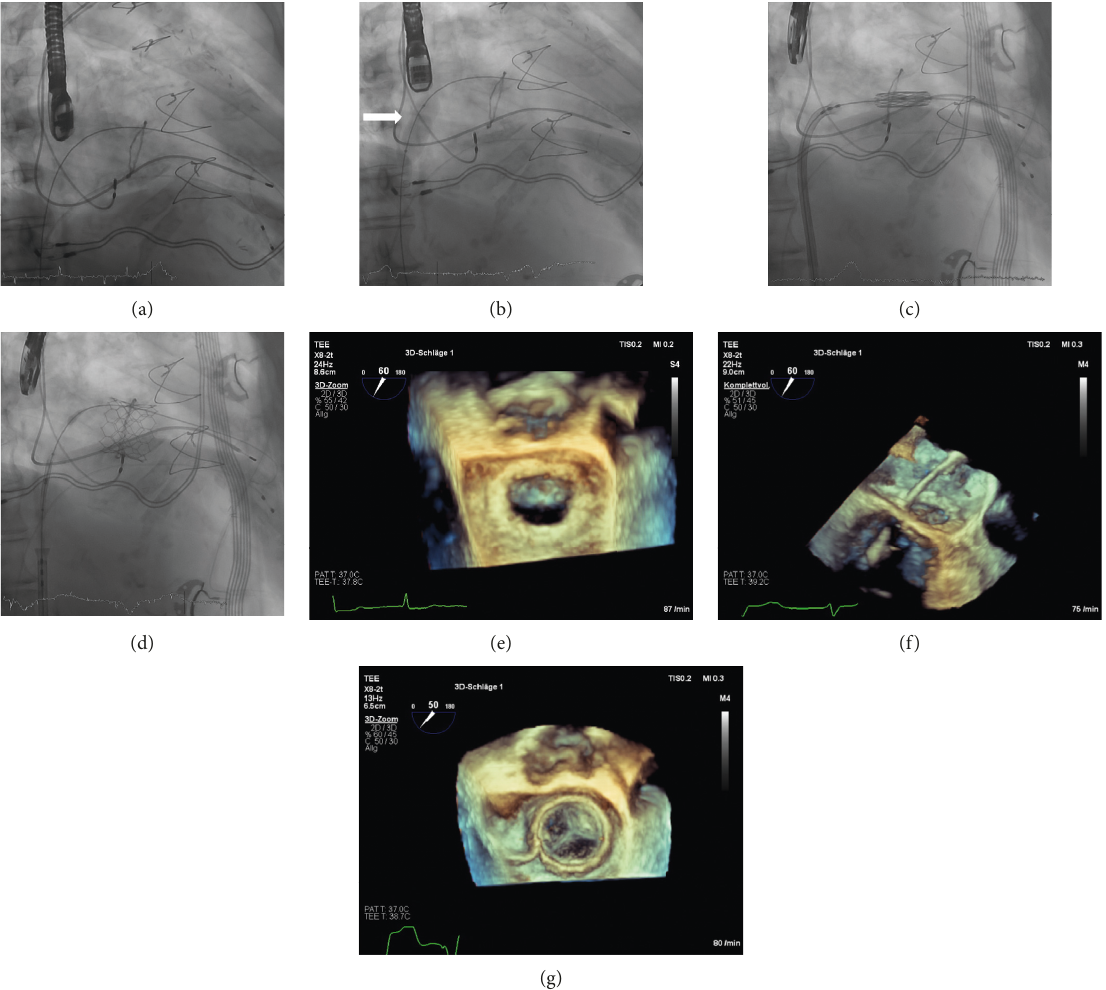
Figure 3: TMVI-R: (a) fluoroscopy shows an Amplatz Super Stiff guidewire (Boston Scientific) inserted in the left ventricle through the 29mm Duran Annuloplasty Ring after transseptal puncture. (b) Fluoroscopy shows balloon dilatation (Osypka VACS II 14 × 30mm Balloon, Osypka AG, Germany ; white arrow) of the interatrial septum to create an artificial atrial septum defect prior to insertion of the prosthesis into the left atrium. (c) Fluoroscopy shows the ES 3 prosthesis after insertion into the Duran Annuloplasty Ring prior to implantation. (d) Fluoroscopy shows the final result after implantation of the ES 3 prosthesis into the 29mm Duran Annuloplasty Ring. (e) 3D-TEE shows the previously reconstructed mitral valve by 29mm Duran Annuloplasty Ring prior to TMVI (view from left atrium). (f) 3D- TEE shows the insertion of the delivery catheter through the reconstructed mitral valve prior to implantation (view from lateral). (g) 3D- TEE showing the final result after implantation of the 29mm ES 3 Prosthesis into the Duran Annuloplasty Ring (view from left